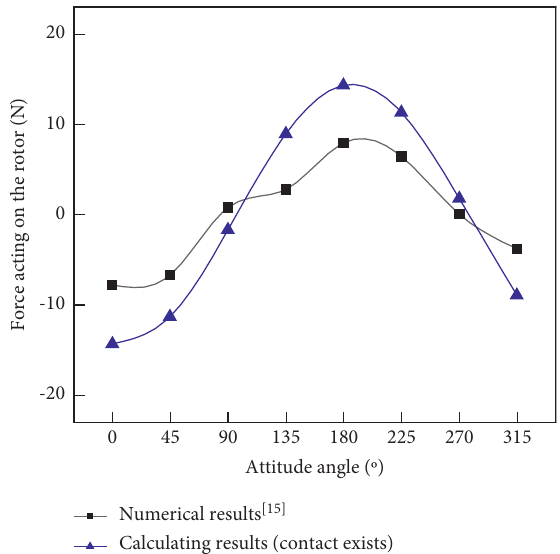
Figure 9: Force acting on the rotor in the z